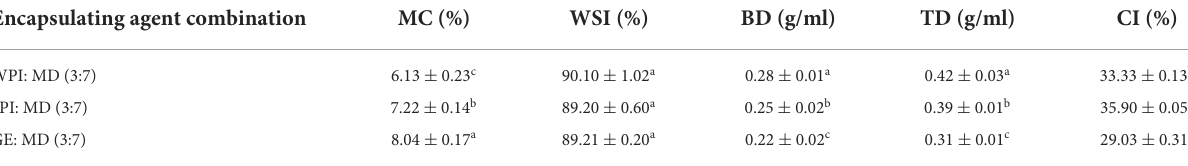
TABLE 2 Physical properties of